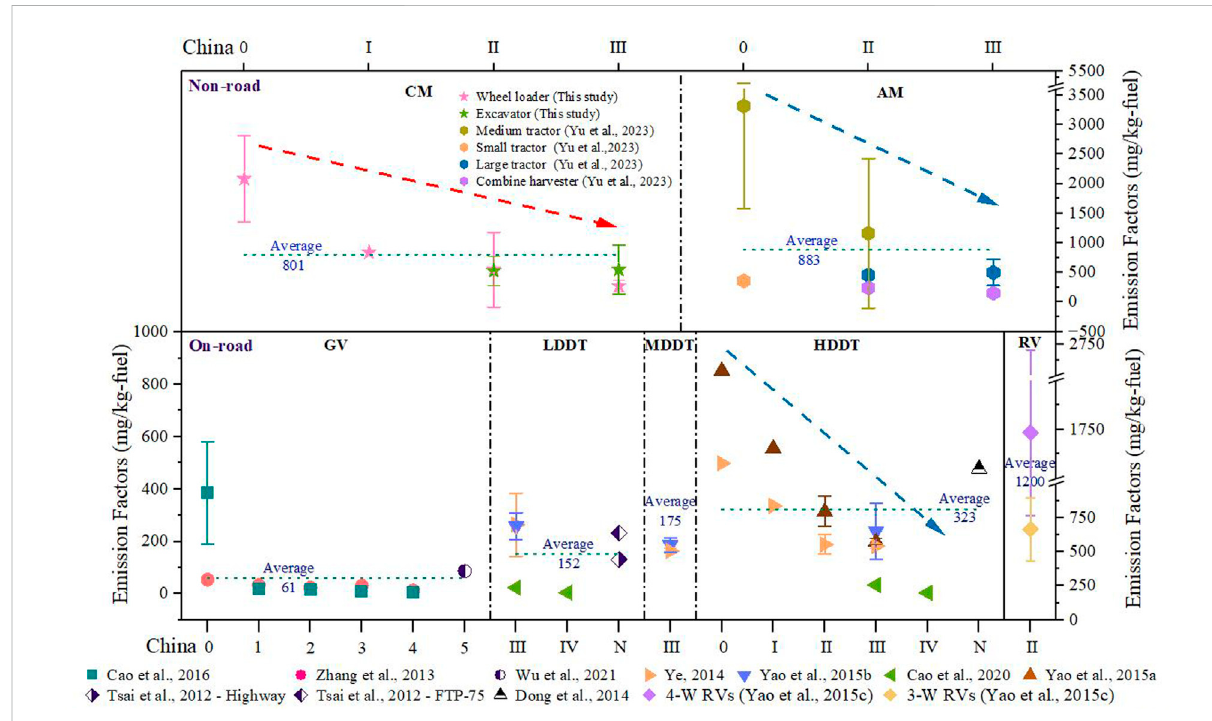
Comparison of the carbonyl compound emission factors of construction machinery in this study to those obtamed in previous studies. Note: The carbon balance method is used to convert emission factors based on mileage from other publications into emission factors based on fuel consumption.CM, AM,GV, LDDT, MDDT,HDDT,RV, 3-W, and4-W denoteconstruction machinery, agriculturalmachinery, gasoline vehicles, light- duty diesel trucks, medium-duty diesel trucks, heavy-duty diesel trucks, rural vehicles, 3-wheel vehicles, and 4-wheel vehicles,